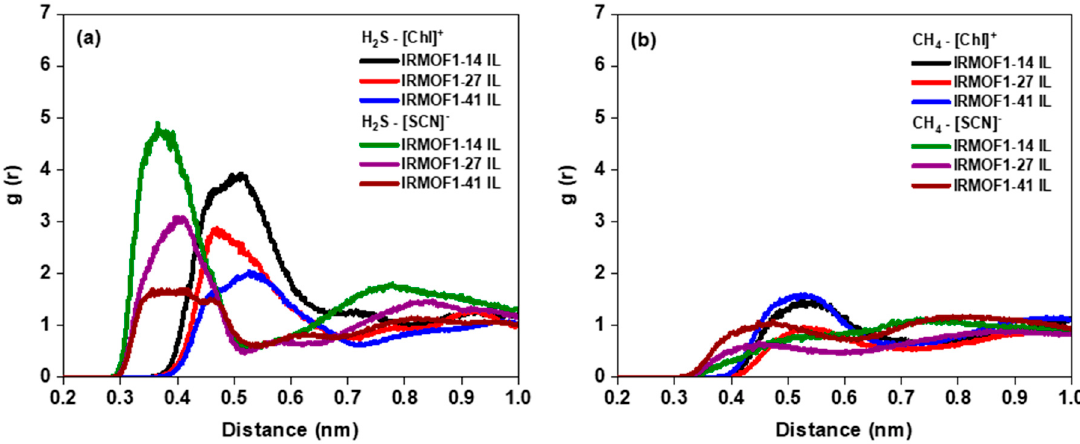
Figure 5. Radial distribution function of ( a ) H 2 S and ( b ) CH 4 interaction towards [Chl][SCN] / IRMOF-1 composite.